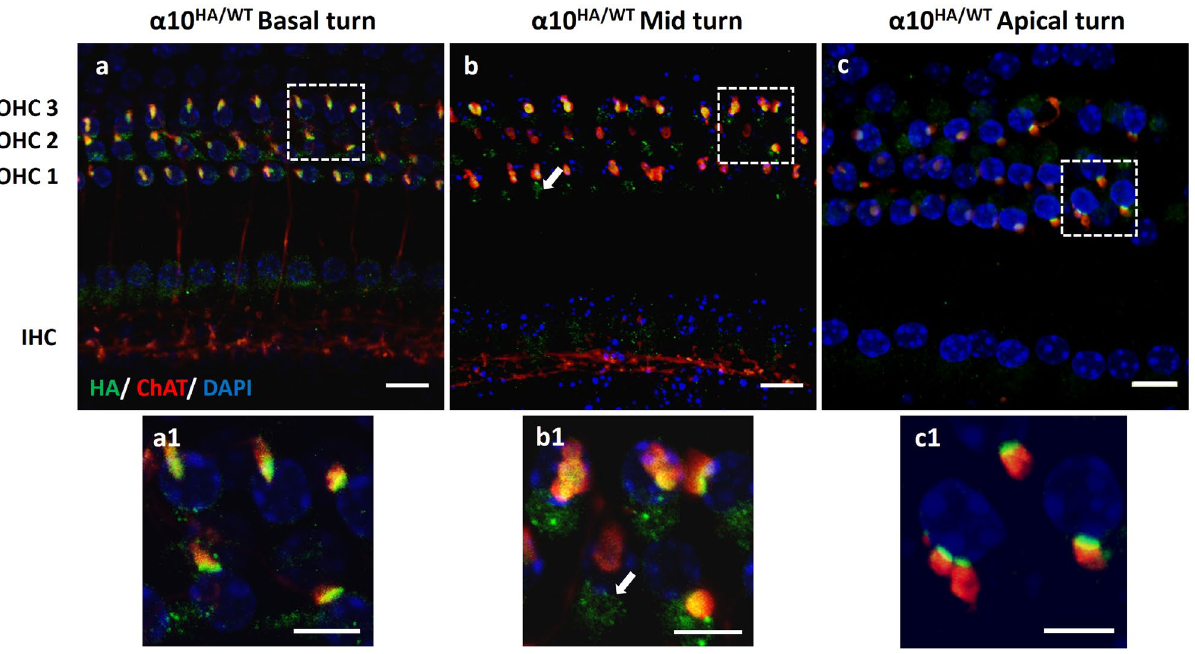
Figure 5. Expression of α10 nAChR subunit in α10 HA/WT adult mouse (P21–P60). Maximum intensity projection images show immunolabeling for MOC terminals (ChAT, red) and HA tagged α10 subunit (green) along the cochlear tonotopic axis. Alpha10HA immunoclusters were juxtaposed and coextensive with ChAT positive efferent terminals beneath the 3 rows of OHCs. Insets represent magnified areas marked by squares in images ( a )–( c ). Subcuticular immunopuncta in OHCs are indicated by arrows ( b , b1 ). The maximum intensity projection image stack in 5c was outside the range of the lateral efferent system. Nuclei are visualized by DAPI staining (blue). Scale bar: ( a )–( c ) 10 µm, ( a1 )–( c1 ) 5 µm. (α10 HA/WT N = 15).